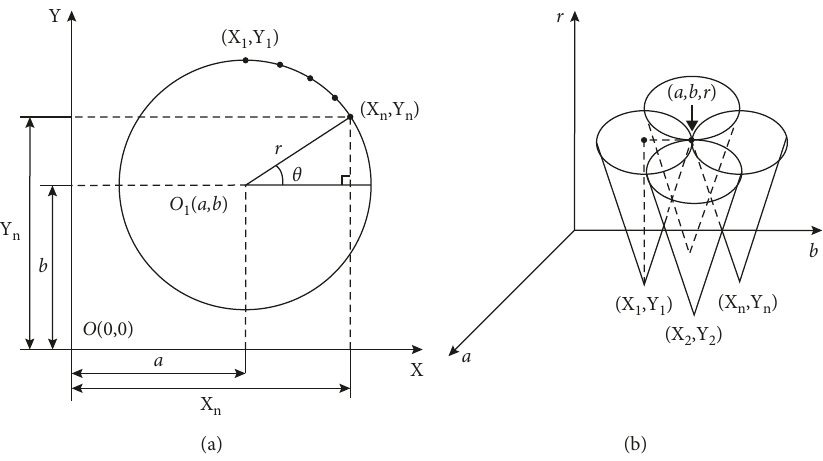
Figure 4: The basic principle of Hough transform circle detection. (a) Image space. (b) Parameter space.